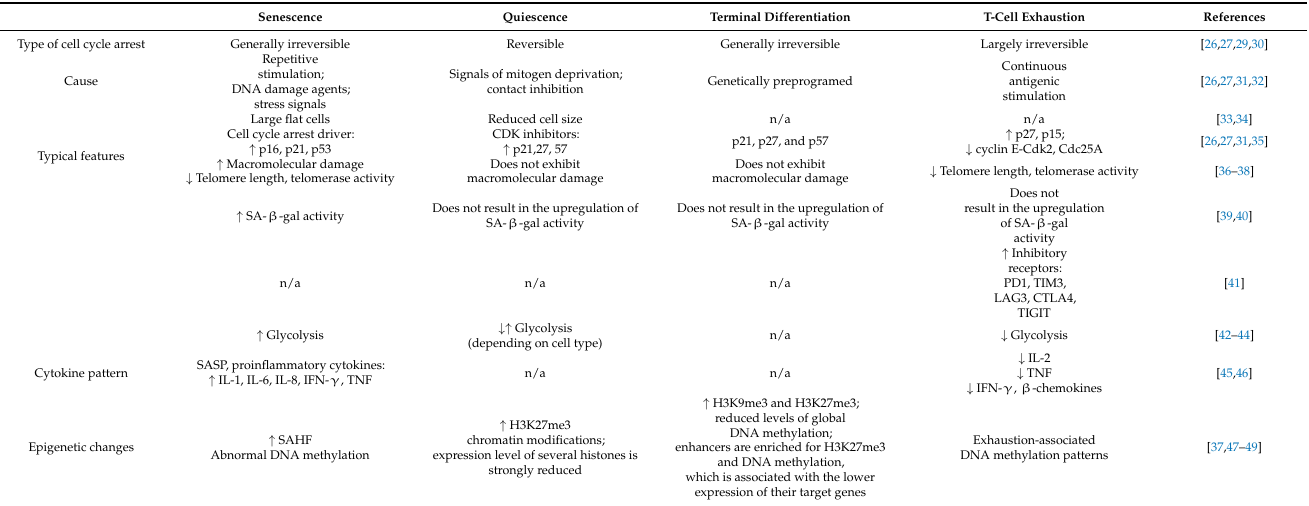
Table 1. Main differences between cell senescence, quiescence, terminal differentiation, and T-cell